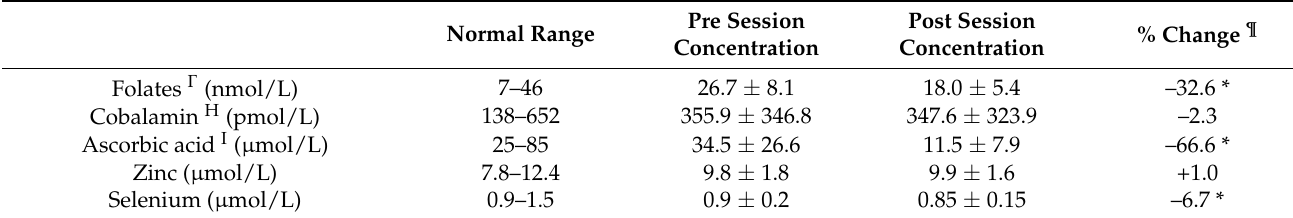
Table 2. Vitamins and trace elements blood concentration before and after one hemodialysis session. Table 2. Cont .